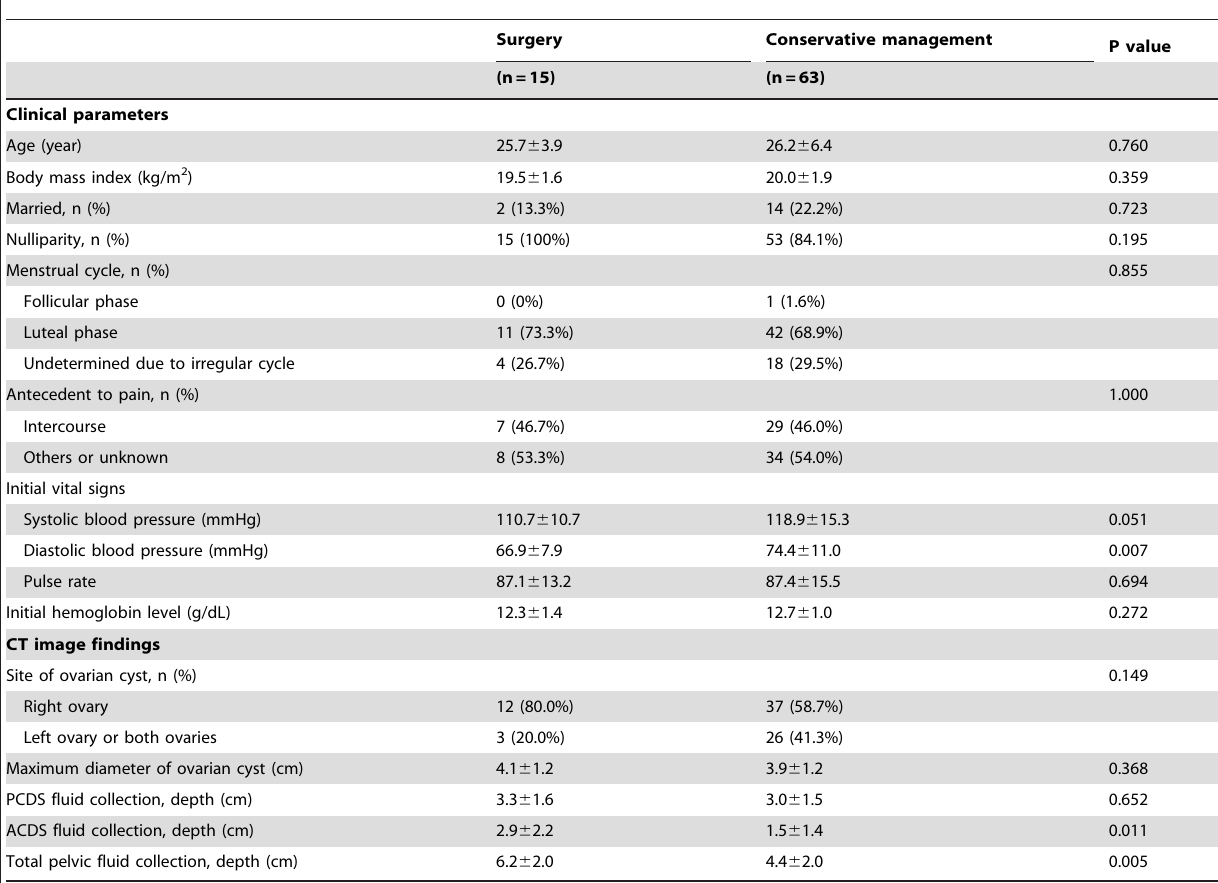
Table 1. Clinical parameters and CT image findings of the patients at initial presentation.